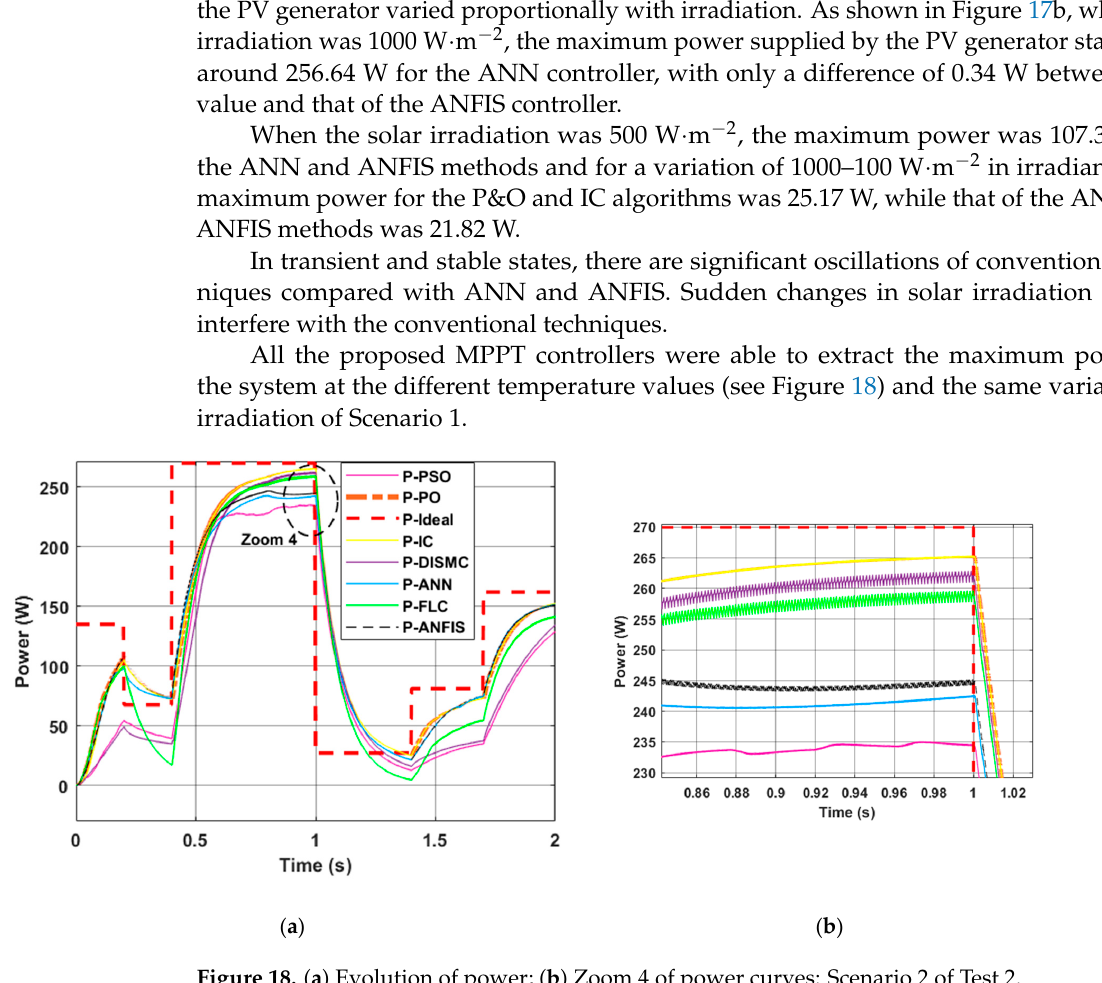
Figure 17. ( a ) Evolution of power; ( b ) Zoom 3 of power curves: Scenario 1 of Test 2.